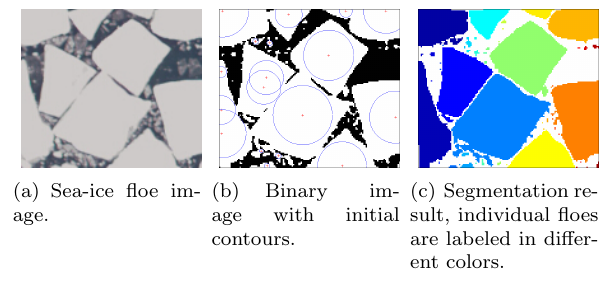
Figure 5: Connected ice floe segmentation based on GVF Snake.